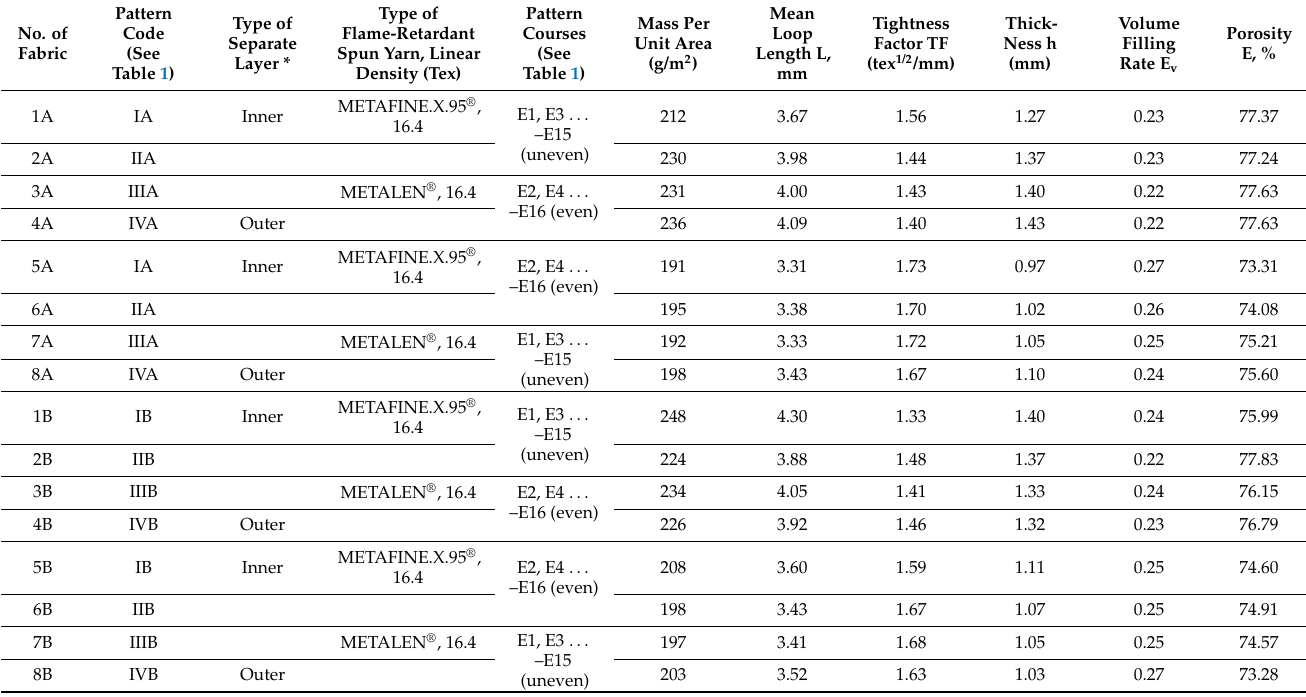
Table 2. The main structural characteristics of two-layer weft knitted fabrics.